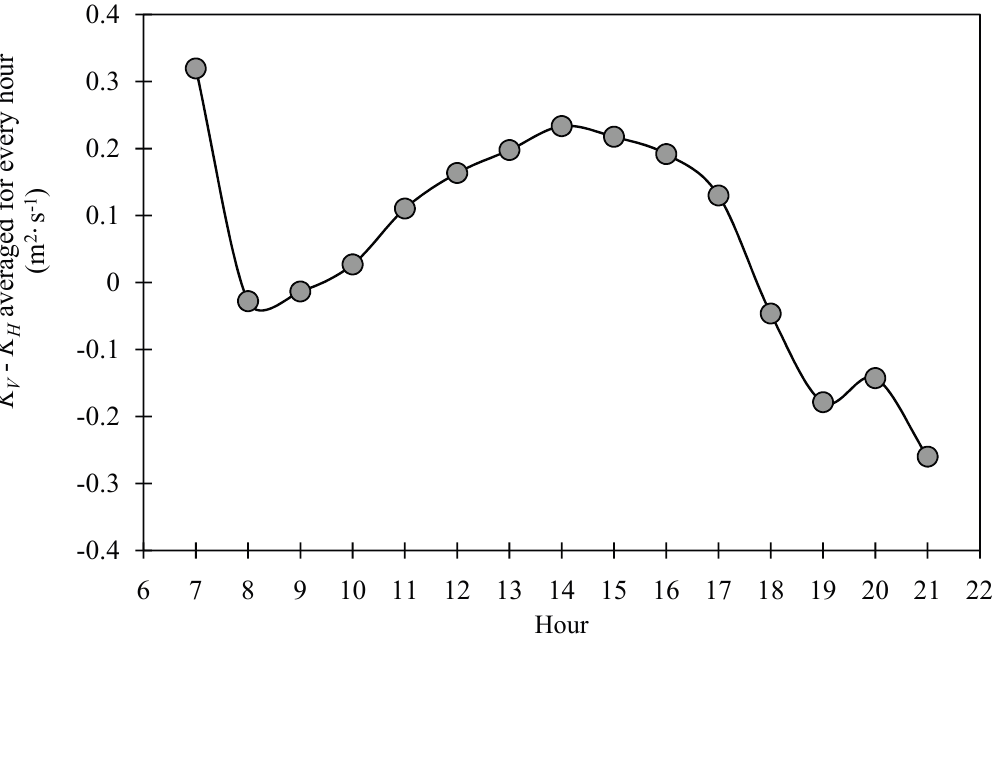
– K estimated for every hour from V H – K for every hour V H